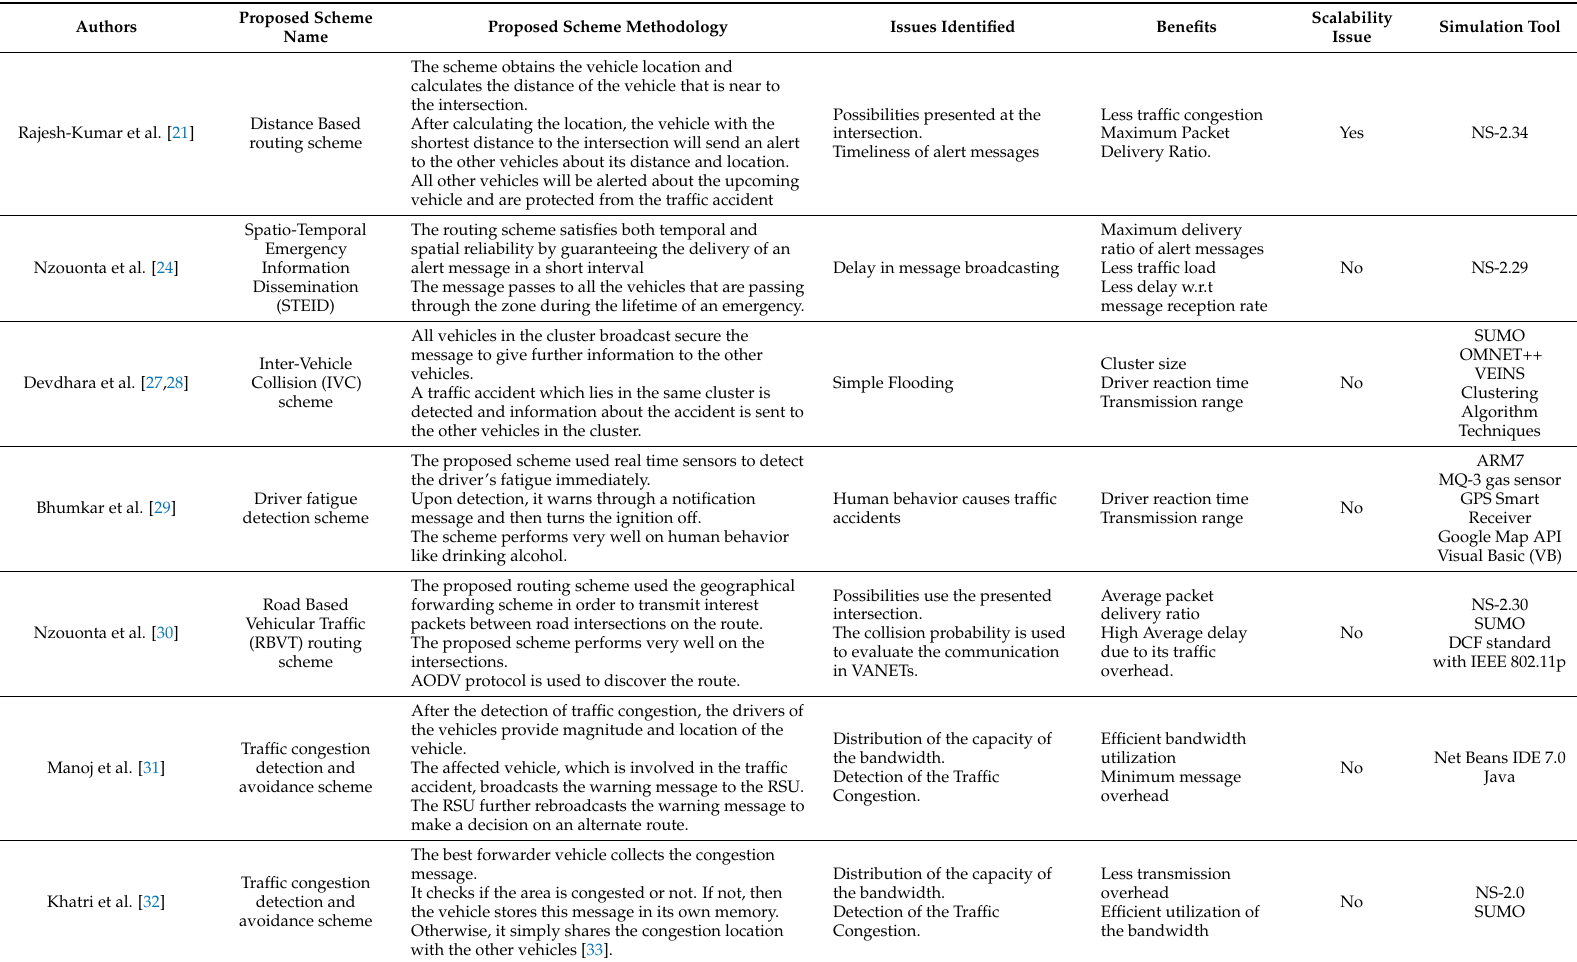
Table 2. Literature review of traffic accident prevention and avoidance schemes based on Routing